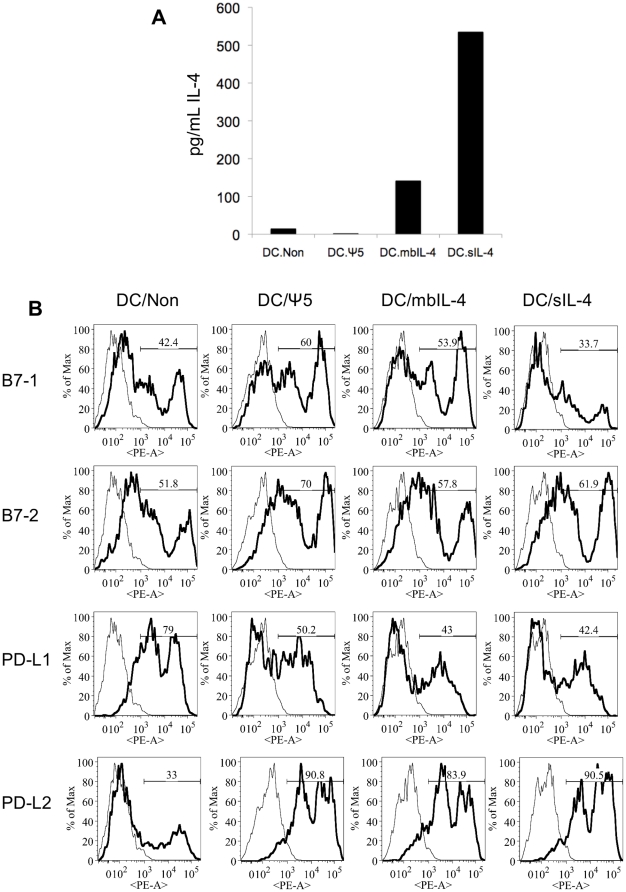
Characterization of DC used for adoptive cellular therapy.DC transduced with adenoviral vectors expressing soluble IL-4 (DC/sIL-4), membrane-bound IL-4 (DC/mbIL-4), or empty adenoviral vector (DC/ψ5) were compared to non-transduced DC (DC/Non) A.) After harvest on day 8, 1×106 DC were plated per well in OPTI-MEM media a 96-well tissue-culture plate. Following 24 hours of culture, supernatants were analyzed by ELISA for levels of IL-4 secretion. B.) After harvest on day 8, DC were collected and analyzed by flow cytometry. Plots were based on live DC as determined by FSC vs. SSC profiles. Thin lines represent the isotype control stained samples, and bold lines represent staining with anti-B7-1, -B7-2, -PD-L1, or -PD-L2 antibodies, as shown. The percentage of cells in the sample with positive staining is displayed.